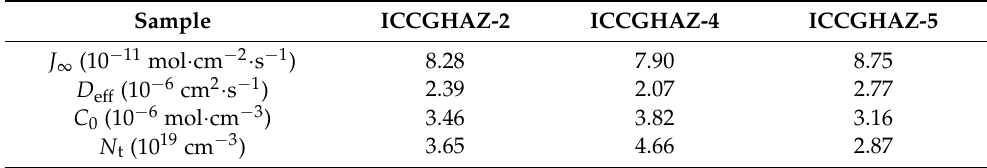
Table 4. Hydrogen permeation parameters of the ICCGHAZs with different cooling